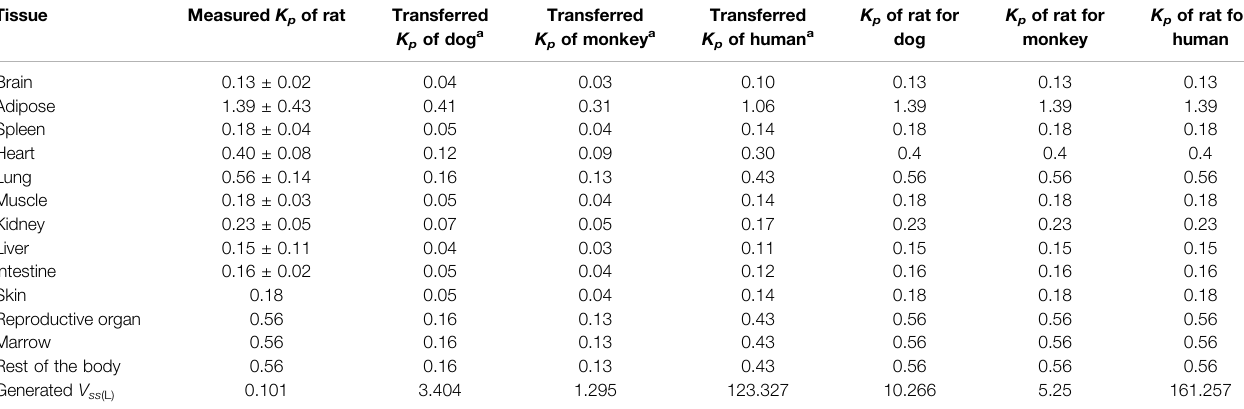
TABLE 2 | Tissue partitions ( K p ) of ST-246 measured in rats and the extrapolated values in dog, monkey, and human PBPK modeling.